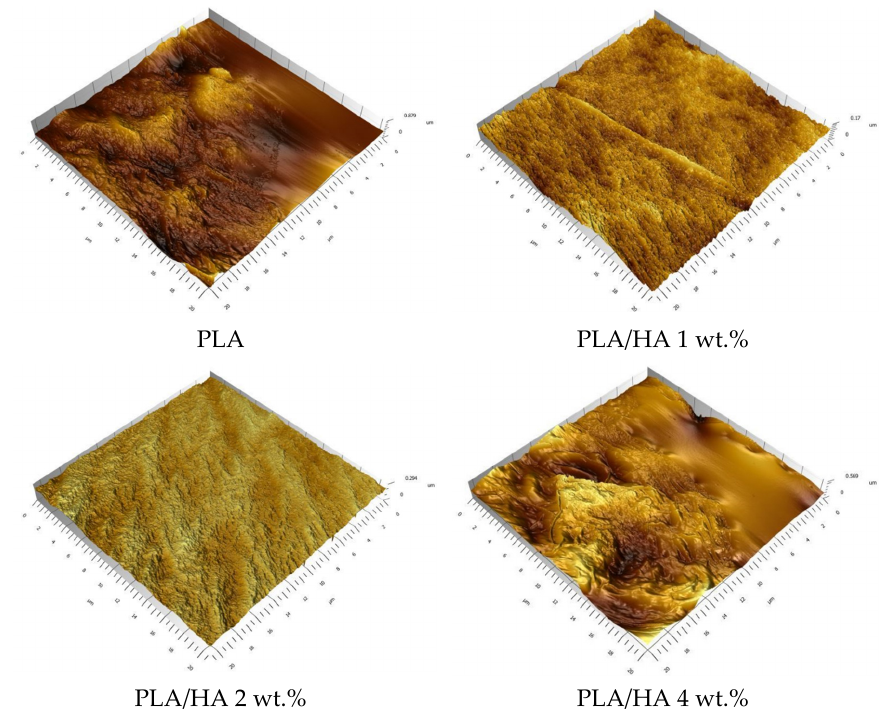
Figure 6. Atomic force microscopy (AFM) images of PLA and PLA/HA composite films.